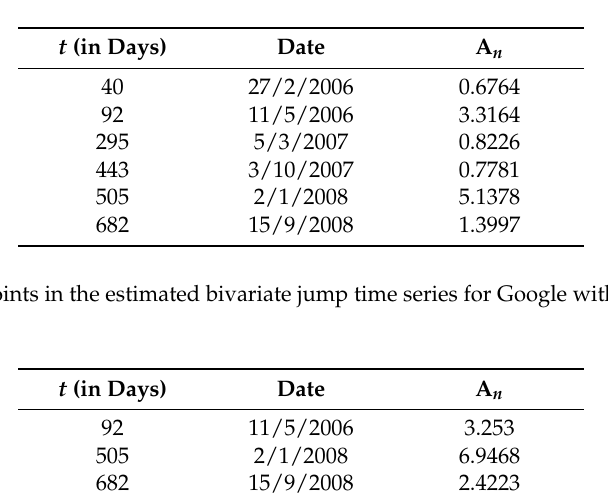
Table 9. Change points for Google with the corresponding test statistic value.